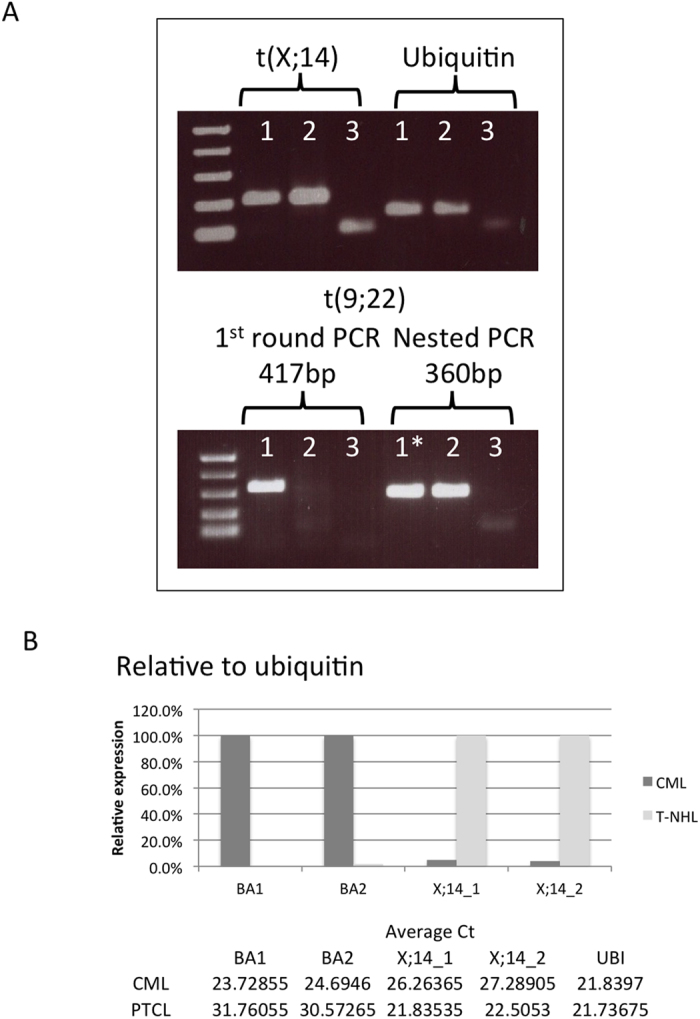
Molecular study of the presence of BCR-ABL1 and t(X;14)-derived fusion transcripts in diagnostic samples corresponding to the two malignancies.(A) End-point qualitative PCR for the translocation product fusions using primers that map up and down stream of the breakpoints. For t(9;22) also nested PCR was performed. Sample legend: 1 – CML (diagnostic PB sample), 2 – T-NHL (diagnostic PB sample), 3 – H2O, * – 1st round PCR product diluted 1:100 before being used as template in nested PCR. The bands visible in the no-template control lanes are due to primer dimer. (B) Quantitative PCR for the fusion gene transcripts. A graph of relative expression and tables of average Cts are shown. The relative quantity was calculated considering the amount of BCR-ABL1, normalised to ubiquitin, as 100% in the diagnostic CML sample and t(X;14) translocation product 100% in the diagnostic lymphoma sample.